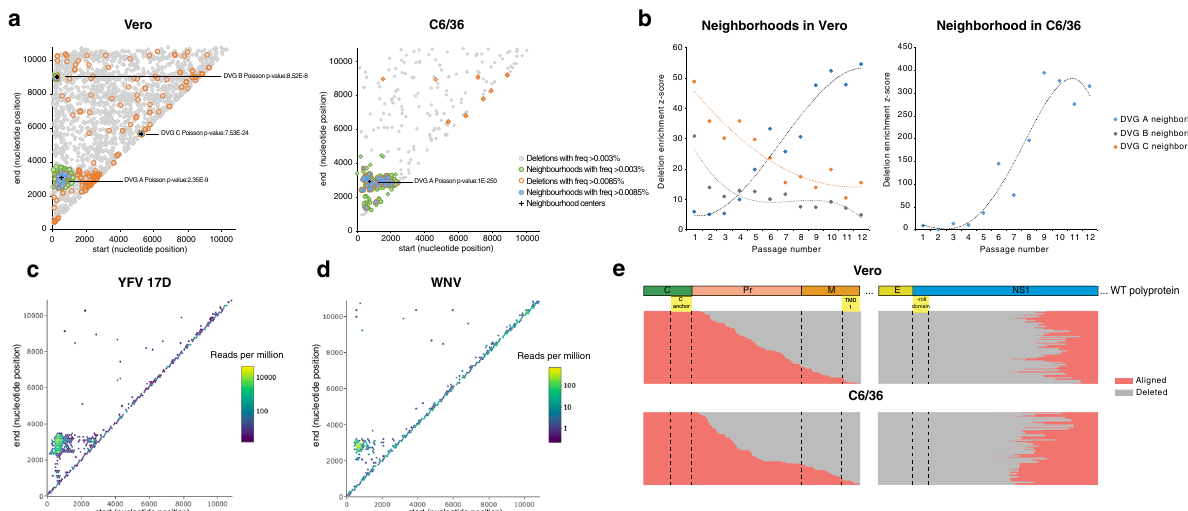
Fig. 1 Identi fi cation and genetic characterization of Zika virus DVGs with high fi tness. Virus populations enriched in DVGs, passaged in Vero or C6/36 cells, were sequenced and deletions identi fi ed. a Computationally-determined neighborhoods enriched with deletions in Vero or C6/36 cells are shown in a 2-dimensional plane representation of the Zika virus genome, with start and end positions of the identi fi ed deletions denoted as dots on the plane. Poisson p values for each neighborhood are shown. b Dynamics of deletion enrichment within DVG neighborhoods identi fi ed in Vero and C6/36 cells. Enrichment z-scores indicate total enrichment signi fi cance of deletions within each neighborhood from all replicates per passage. c , d Hexbin plot of deletions identi fi ed following Yellow fever virus 17D ( c ) or West Nile virus high MOI passaging in SW-13 or C6/36 cells, respectively. Identi fi ed deletions with de fi ned start and end positions within each hexagon (>10 nt in length, bin = 100) are shown. The color of each hexagon is relative to the sum of the reads per million of deletions in all passages and replicates. For YFV, passages number 1, 8, 14, and 19 ( n = 12) were sequenced and shown. For WNV, data from all passages and replicates ( n = 3) are shown. e Putative Zika virus DVG-A genomes identi fi ed in Vero or C6/36 cells that conserve the open reading frame aligned against the Zika virus polyprotein. Aligned regions are shown in pink and deleted regions in gray. Dashed lines denote limits of proteins or relevant protein domains. Source data are provided in the Supplementary Data 1 and 2 for Vero and C6/36 data, respectively, and in Supplementary Data 3 and 4 for Yellow fever virus and West Nile virus,